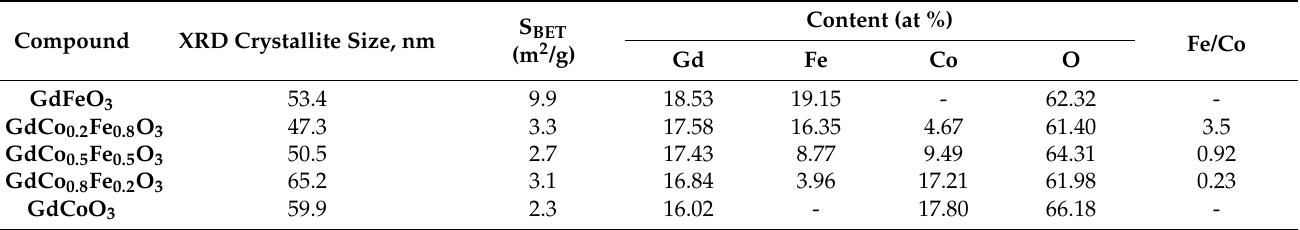
Figure 1. Dependence of structural parameters a, b and c on composition GdCo x Fe 1 − x O 3 (x = 0; 0.2; 0.5; 0.8; 1). Table 1. Results of studying GdCo x Fe 1 − x O 3 (x = 0; 0.2; 0.5; 0.8; 1) surface composition by X-ray spectral, microanalysis, XRD crystallite size and S